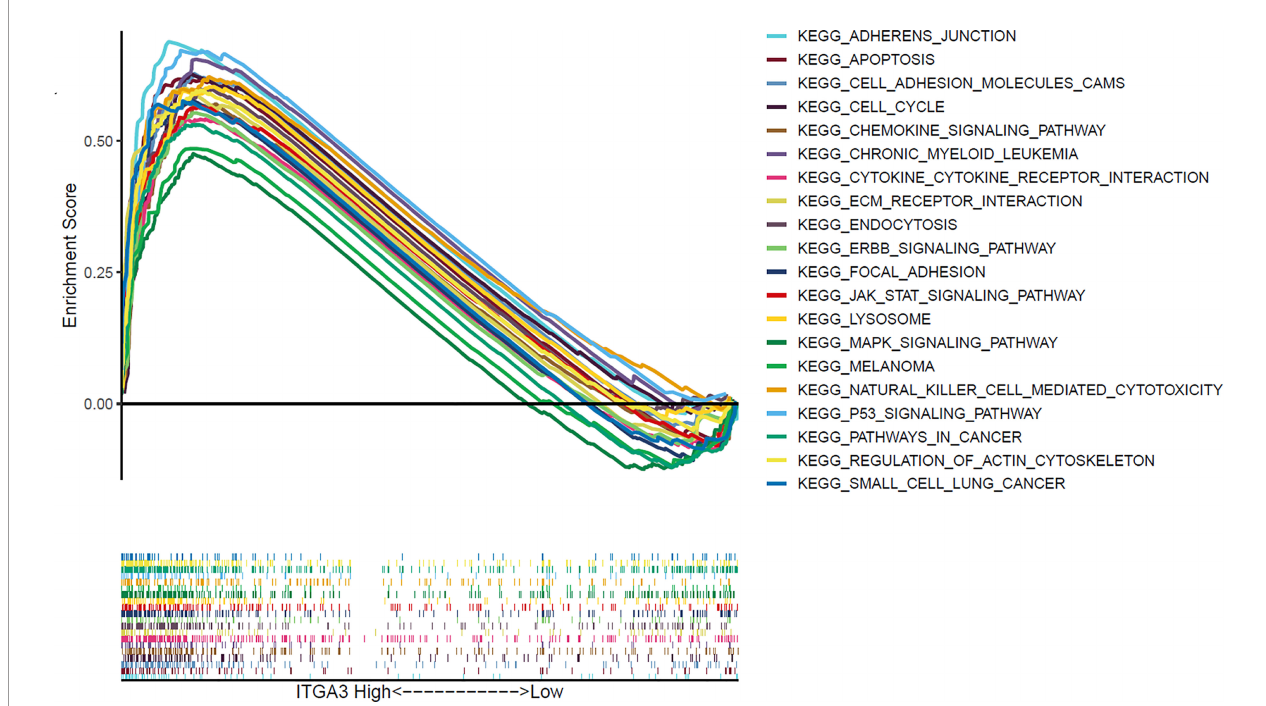
FIGURE 7 | Gene set enrichment analysis of signaling pathway based on ITGA3 expression in TCGA cohort of thyroid cancer.